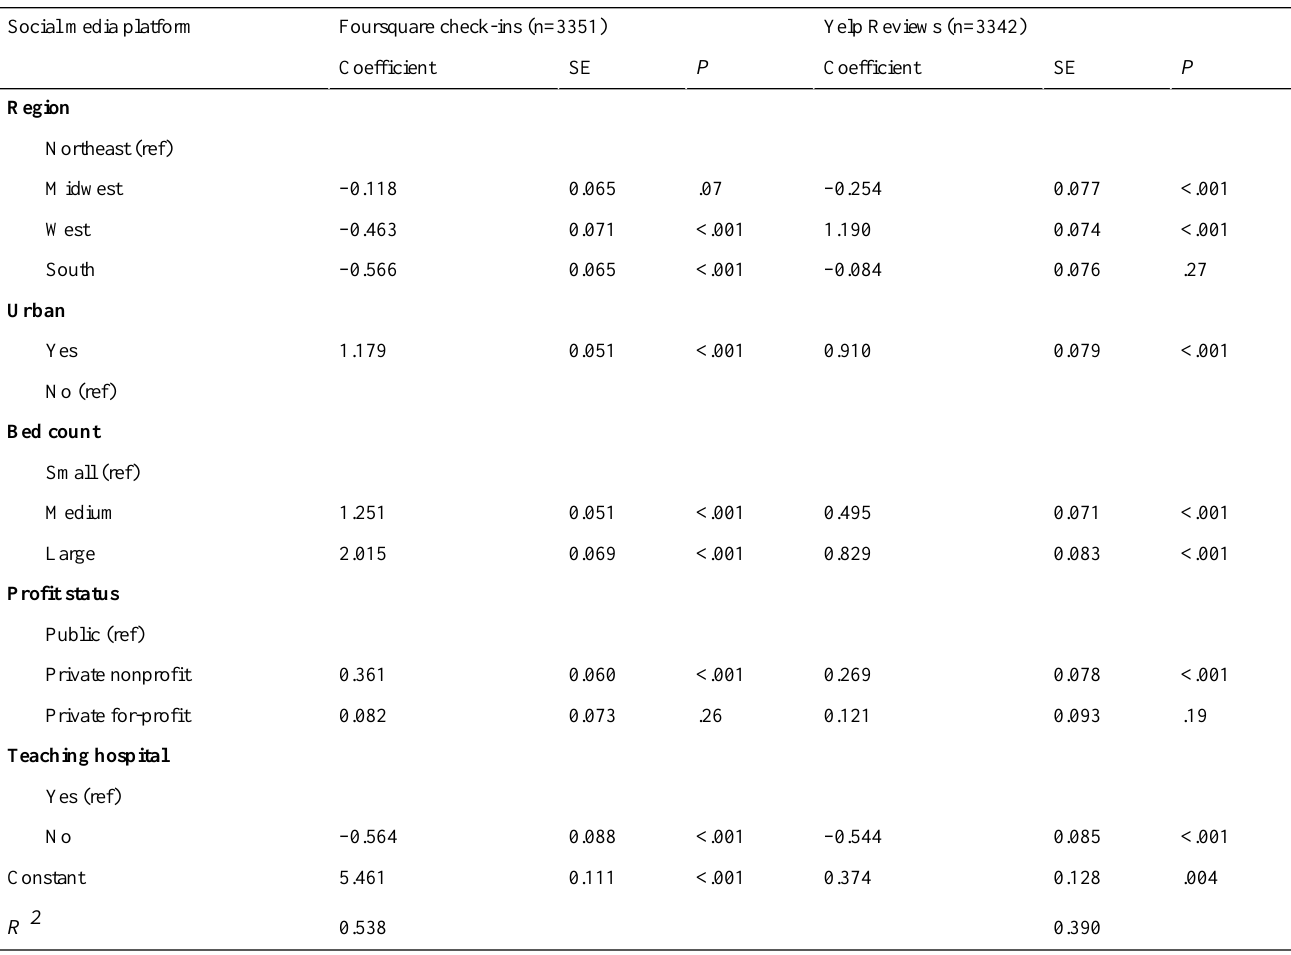
Table 4. Ordinary least squares regression of social media utilization relative to hospital characteristics: Foursquare and